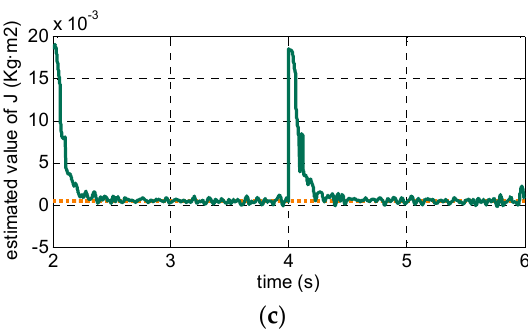
Figure 14. Experimental results under an acceleration of ±420 rpm/s for J 0 = 20 J : ( a ) Measured speed, ( b ) observed disturbance value for parameter mismatch error Δ J ; ( c ) estimated value of parameter J .